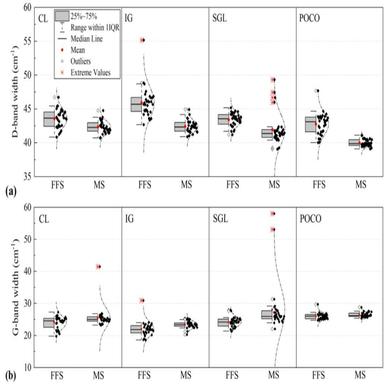
Boxplot of D- and G-band FWHM from both FFS and MS comparing four different grades of graphite with (a) D-band FWHM and, (b) G-band FWHM. Each box is derived from 30 Raman spectra. X-axis is labelling FFS and MS for each grade.